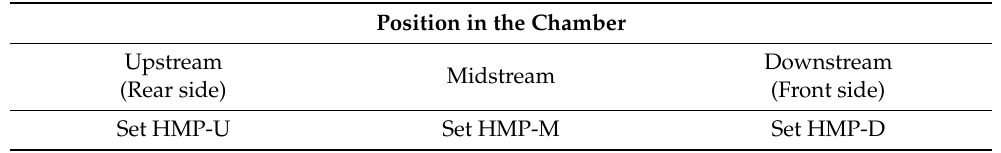
Table 2. Experimental design involving three sample sets fabricated at upstream, midstream and downstream